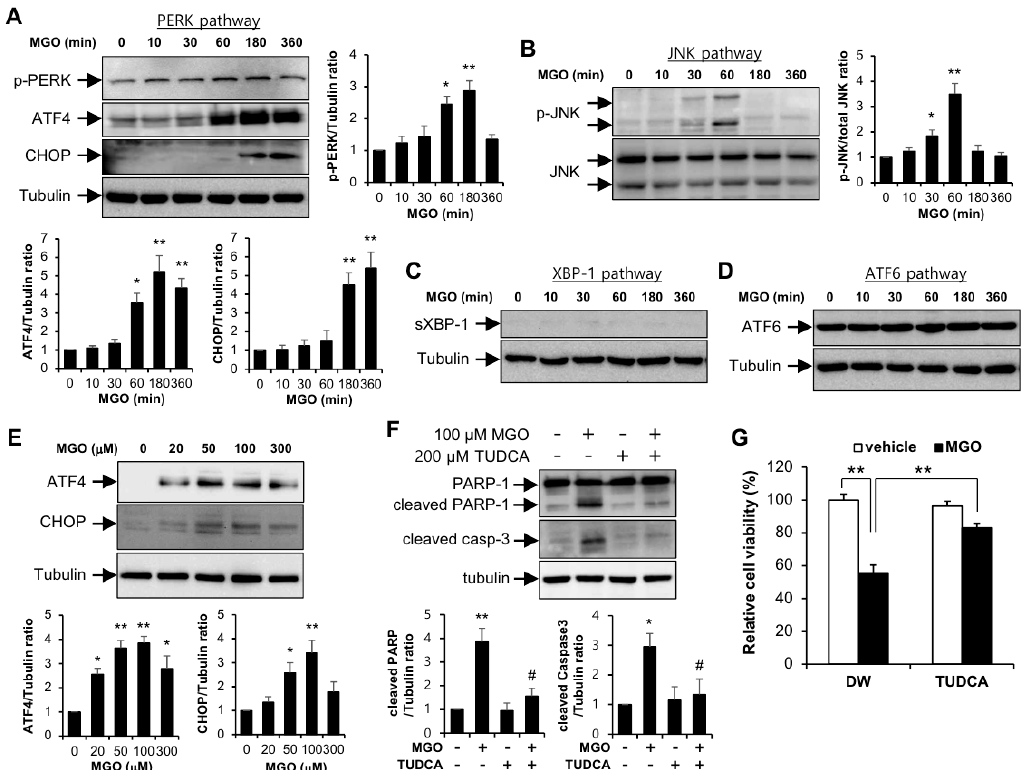
Figure 1. MGO induces endothelial apoptosis via unfolded protein responses in HUVECs. HUVECs were stimulated with 100 µM MGO for the indicated time periods. Protein levels were analyzed by immunoblotting with specific antibodies as follows: ( A ) anti-phospho-PERK, anti-phospho-eIF2 α , anti-ATF4, anti-CHOP, and anti-tubulin antibodies; ( B ) anti-phospho JNK, anti-JNK, and anti-tubulin antibodies; ( C ) anti-spliced XBP-1 and anti-tubulin antibodies; ( D ) anti-ATF6 and anti-tubulin antibodies. Bar graphs represent the densitometric results of Western blot bands. * p < 0.05 and ** p < 0.01 vs. vehicle control ( n = 3). Results are representative of three independent experiments. ( E ) HUVECs were exposed to the indicated doses of MGO for 6 h and cell lysates were applied for immunoblotting using specific antibodies against ATF-4, CHOP, and tubulin. The graph shows the densitometric quantification of Western blot bands. * p < 0.05 and ** p < 0.01 vs. vehicle control ( n = 3). Results are representative of three independent experiments. ( F ) HUVECs were exposed to vehicle or 100 µM MGO in the presence or absence of TUDCA (200 µM). Cells were lysed and then applied for Western blotting analysis. Protein level amounts were determined by immunoblotting with specific antibodies against PARP-1 and caspase-3. The graph shows the densitometric quantification of Western blot bands. * p < 0.05 and ** p < 0.01 vs. vehicle control, # p < 0.05 vs. MGO-treated cells ( n = 3). Results are representative of three independent experiments. ( G ) MTT assay was performed as described in the Materials and Methods section. Results are expressed as means ± SDs and are representative of three independent experiments. ** p < 0.01 ( n = 3).